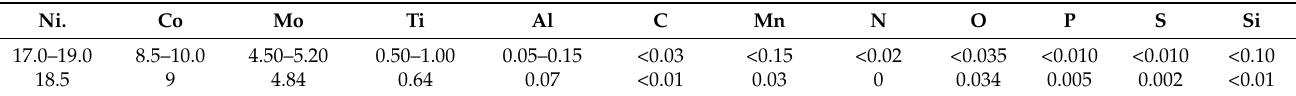
Table 1. Nominal and certified composition (wt.%) of the 18Ni300 maraging steel powders produced by Höganäs (Amperprint ® 1556.074).